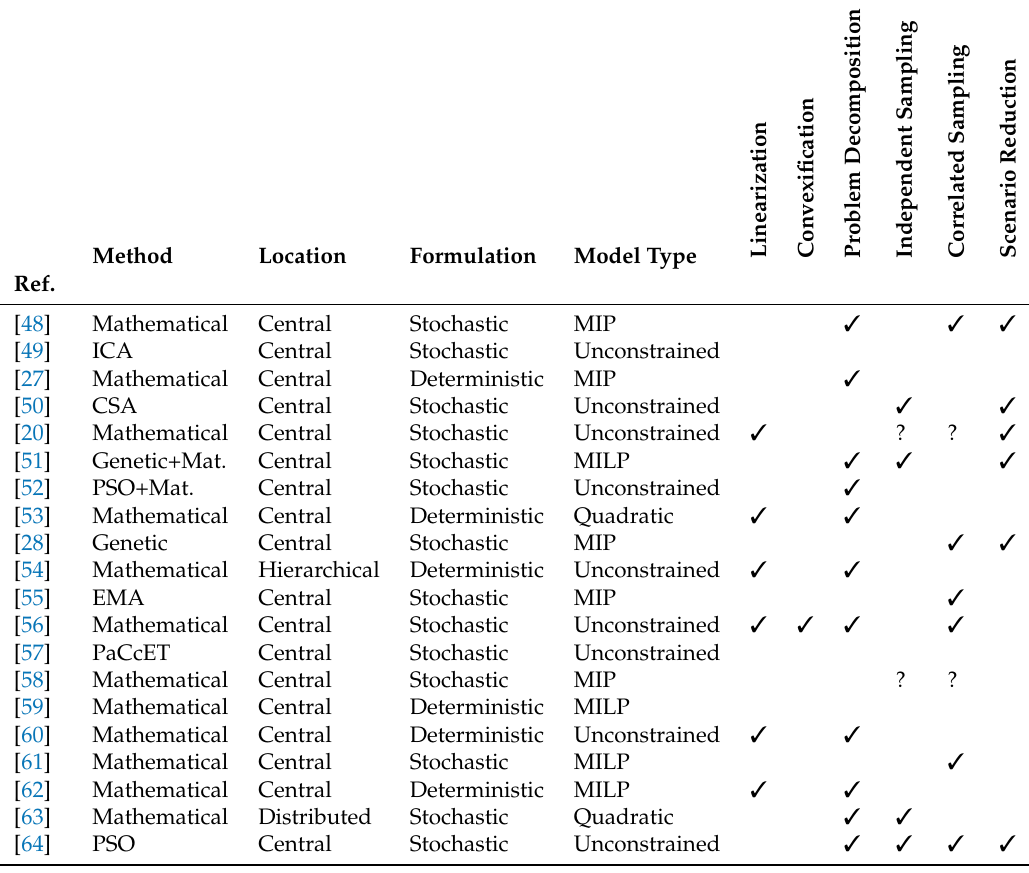
Table 5. Optimization approaches ( (cid:51) : Implemented, ?: Not reported)